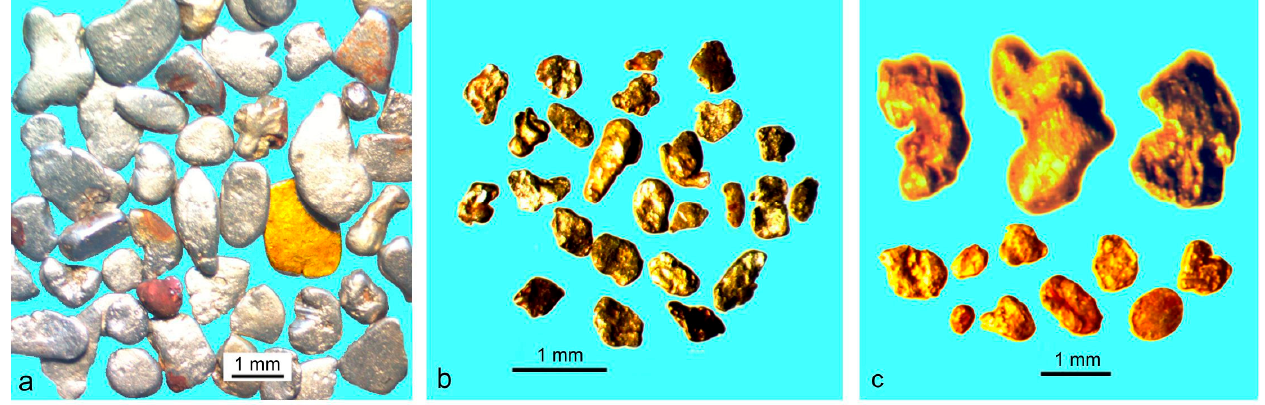
Figure 2. Morphology of platinum and gold mineral grains from the placer of the Mayat river: ( a ) well-rounded flattened grains of platinum (gray) with gold (yellow); ( b ) palladium gold; ( c ) large lumpy (upper row) and small scaly grains (lower row) of